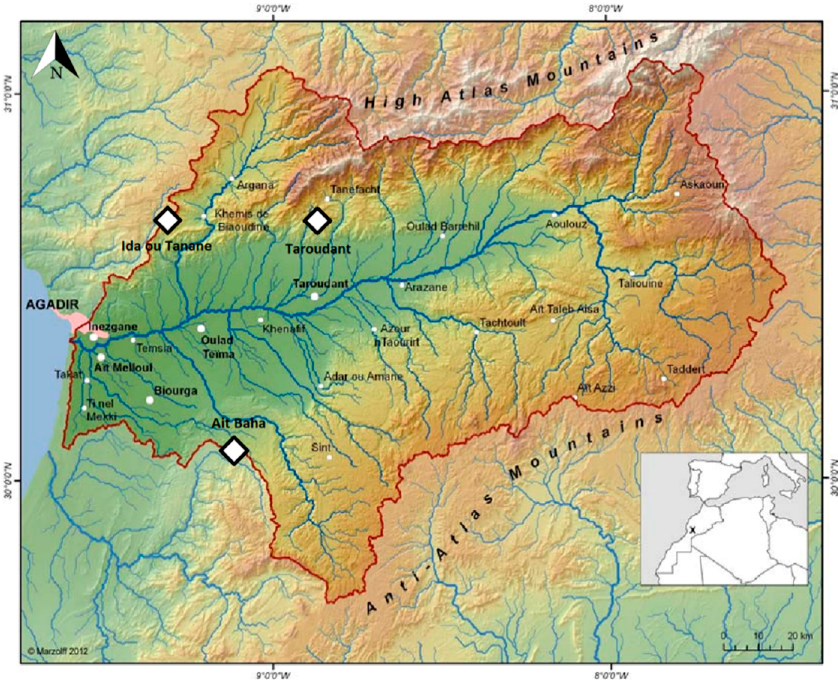
Figure 2. Study areas in the Souss basin (modified from d’Oleire-Oltmanns [30]).